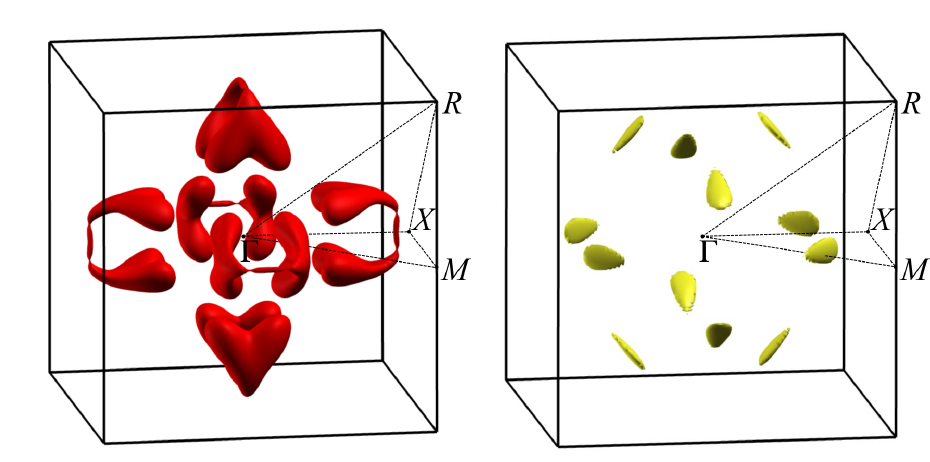
Figure 11. Constant-energy surfaces of valence ( left ) and conduction bands ( right ) of FeSi at energies of VBM and CBM. Energies of VBM and CBM are shown in Figure 2 by dotted